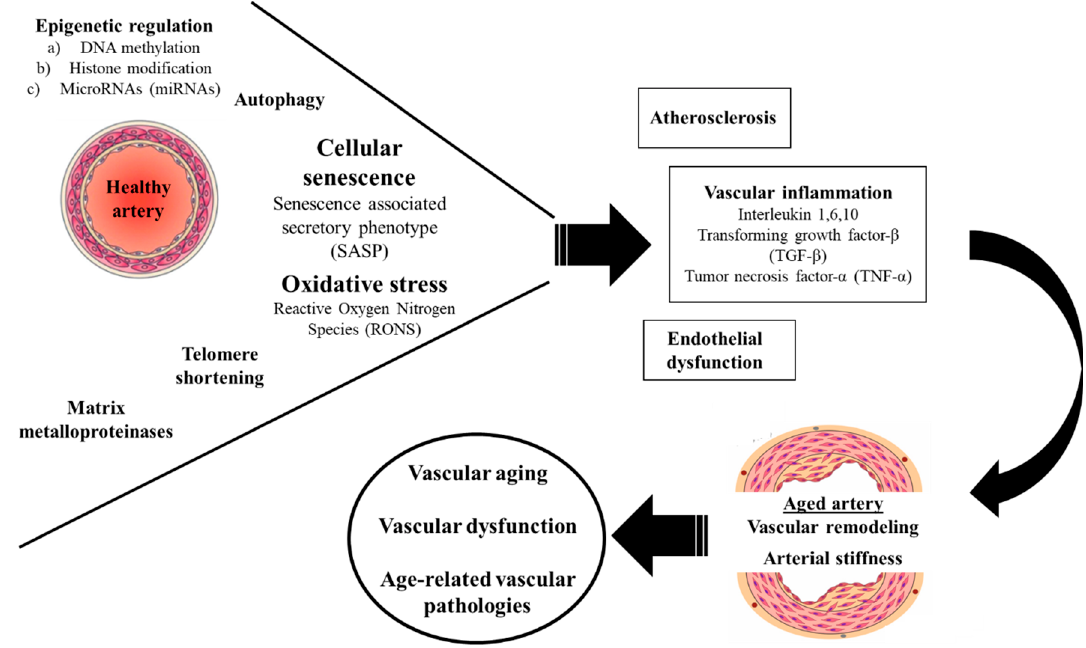
Figure 1. Molecular mechanisms of vascular aging. Oxidative stress, cellular senescence, telomere shortening, epigenetic regulation, matrix metalloproteinases and autophagy represent the main pathophysiological mechanisms mediating inflammation, atherosclerosis and endothelial dysfunction, finally leading to vascular ageing.